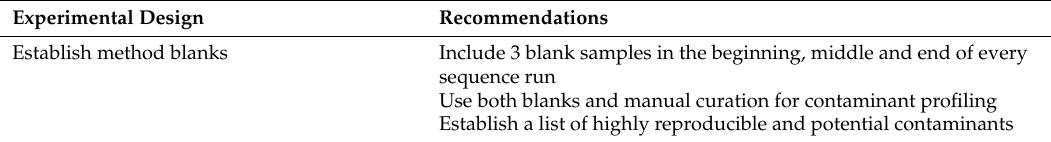
Table 5. Recommendations for experimental design of GC-MS-based non-targeted profiling of human plasma metabolome, including recommendations on the inclusion of blanks, applications of linearity, control for repeatability and intermediate precision, establishment of linear range and treatment of